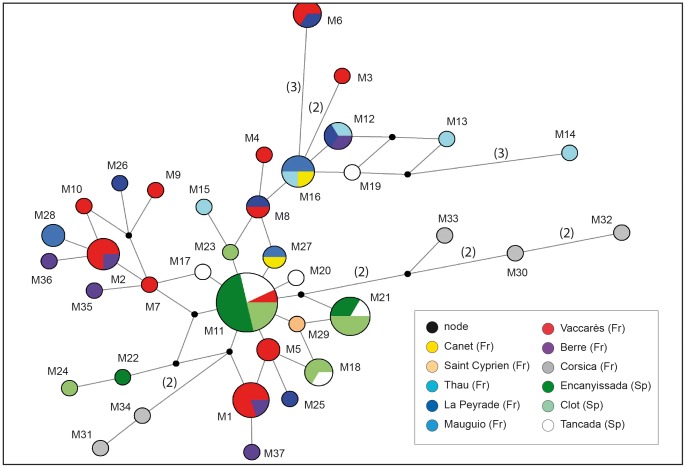
Median-joining network of the concatenated control region and cytochrome b gene haplotypes for Pomatoschistus microps of the Mediterranean lineage.Haplotypes are indicated by numbers as given in Table S1. Line lengths reflect the number of mutational changes (in brackets when >1) between haplotypes.